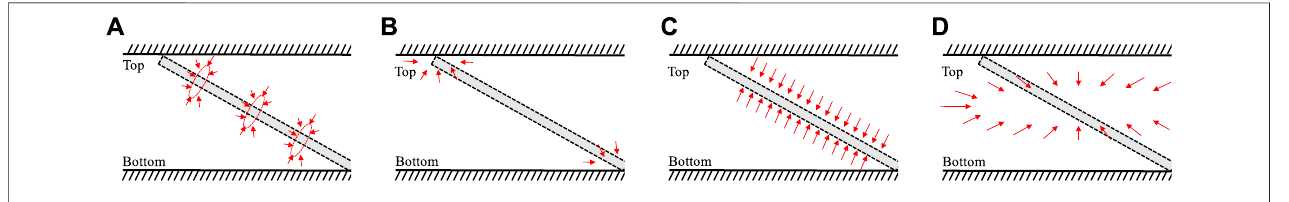
FIGURE 7 | Main regime fl ow schemes for inclined